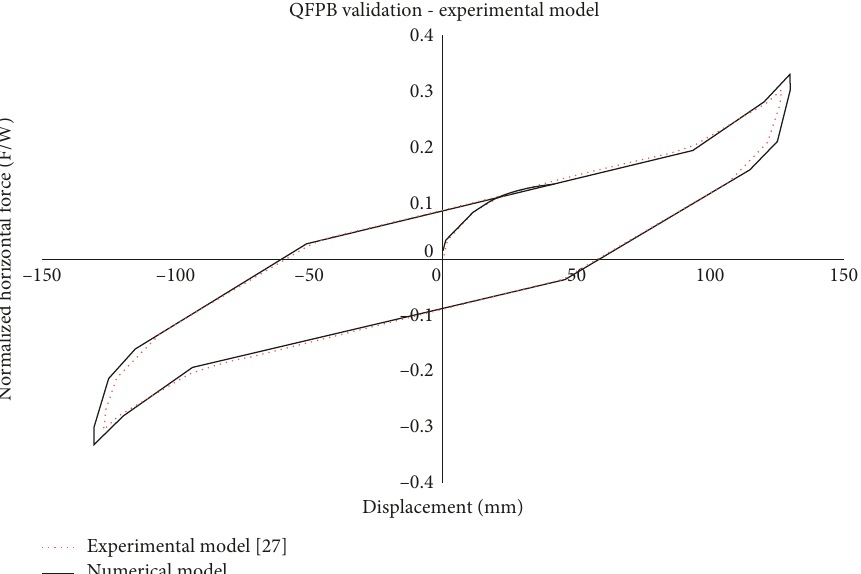
Figure 4: Comparison of current numerical QFPB model with experimental results derived from Lee and Constantinou [21].